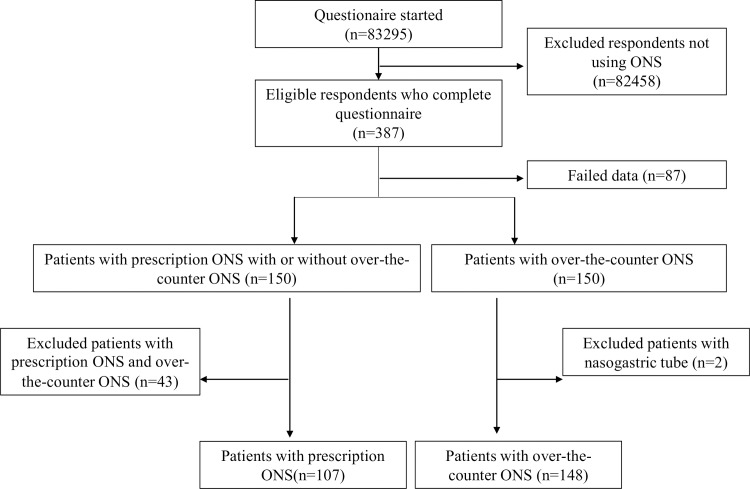
Flow chart of participants in the overall survey.